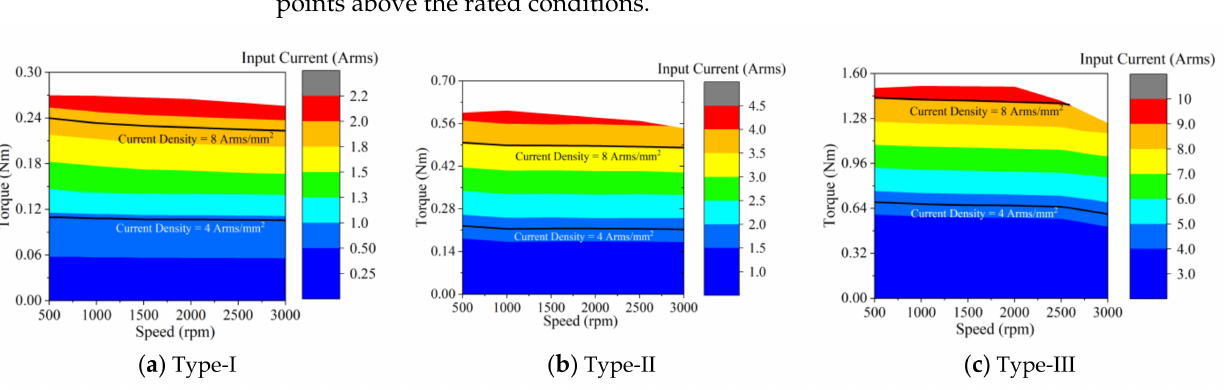
Figure 14. Load test result: input current map for three types: ( a ) Type-I; ( b ) Type-II; and ( c )